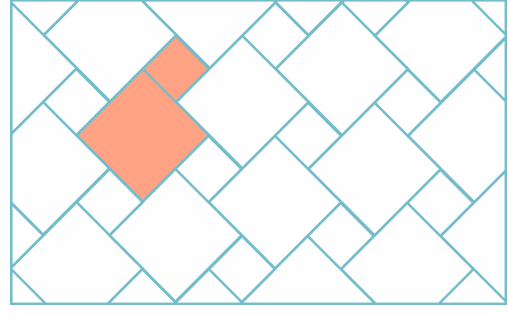
Figure 7. Complex basic geometry example.